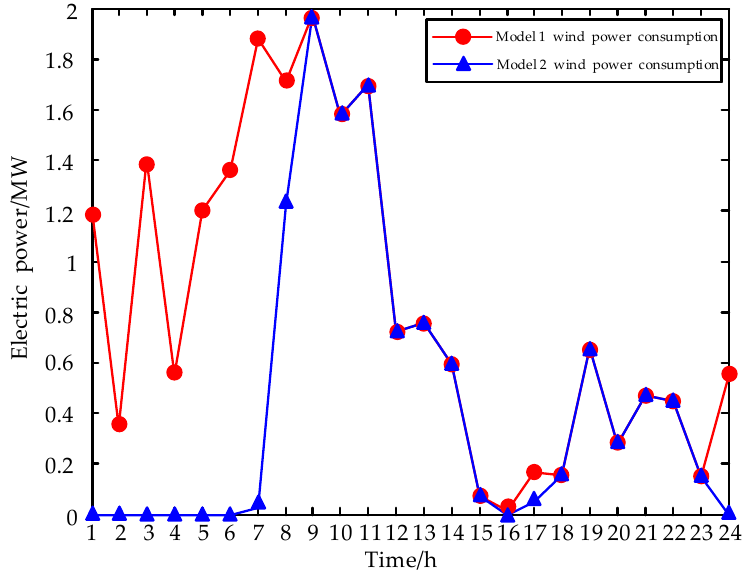
Figure 9. Comparison of wind power accommodation under different models.